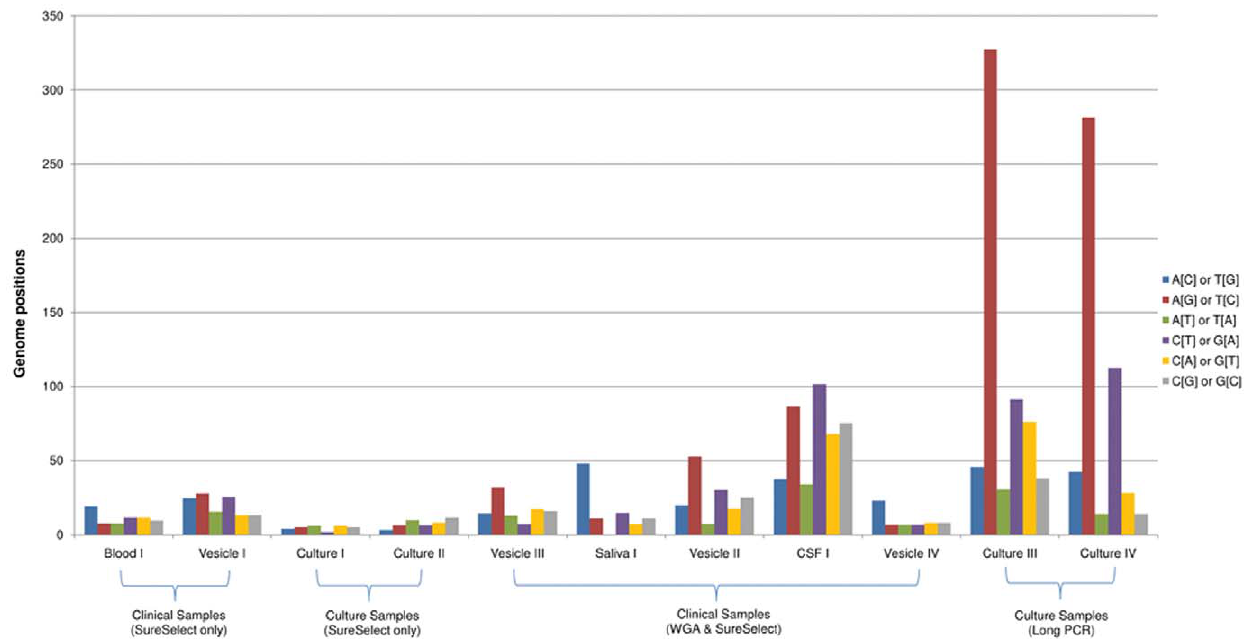
Figure 3. Mutational spectra of minority variants occurring within clinical samples. Each bar indicates the number of genome positions at which specific allele combinations (see graphic) are present (minor allele frequency 1–10%). Datasets are normalised (corrected for the total number of mapped reads per sample) and show a clear bias toward A to G and T to C substitutions in samples prepared by long PCR. No bias was observed in samples prepared using target enrichment